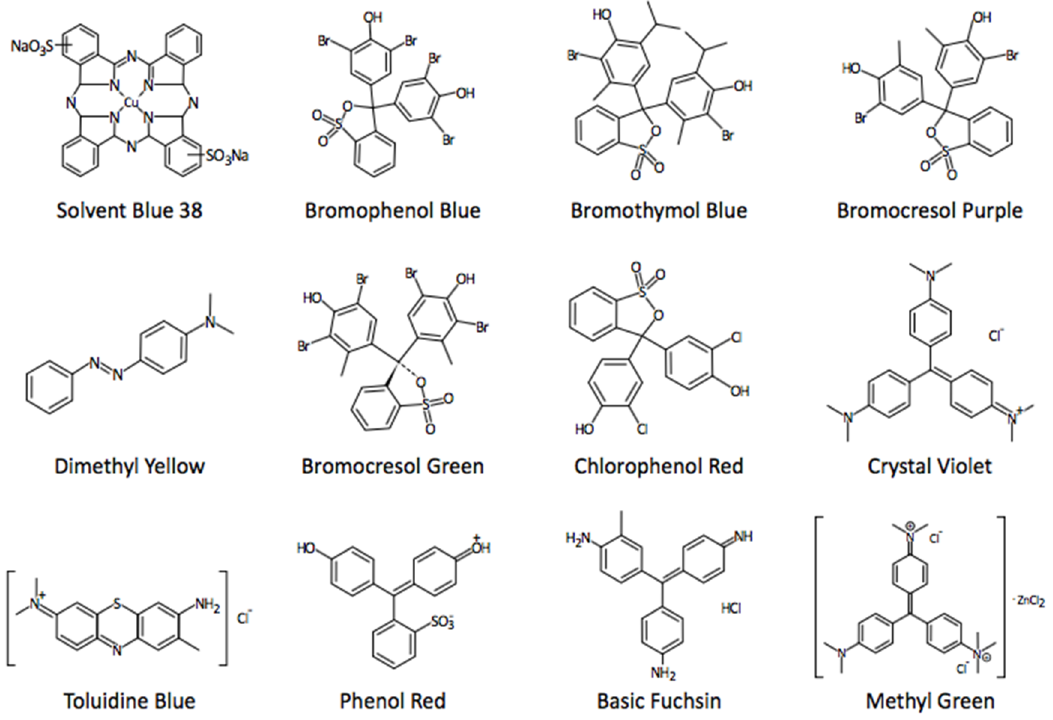
Figure 1. The chemical structures of a selection of the pH and redox sensitive dyes used in the investigation.